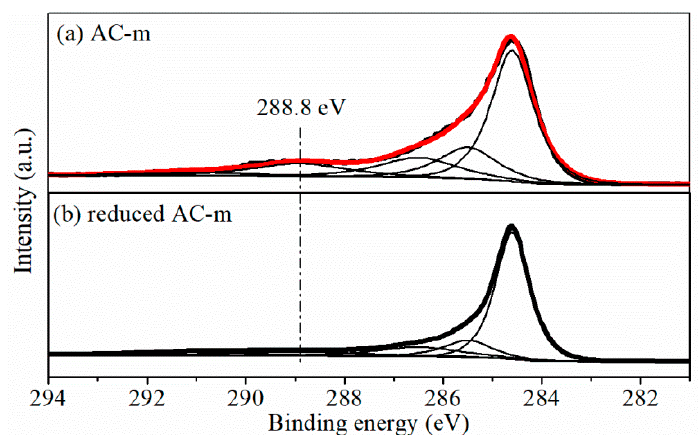
Figure 11. N 2 adsorption/desorption isotherms ( a ) and pore size distribution using DFT model ( b ) of the reduced AC-m.